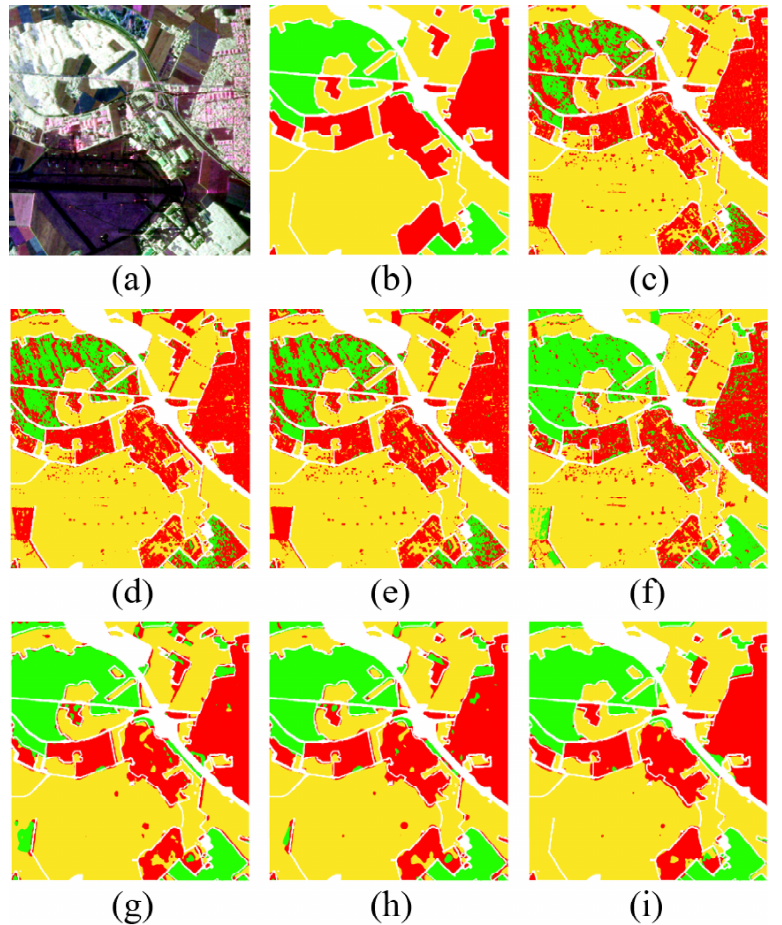
Figure 10. Results of the Oberpfaffenhofen dataset: ( a ) pseudocolor image; ( b ) ground truth; ( c ) CNN;